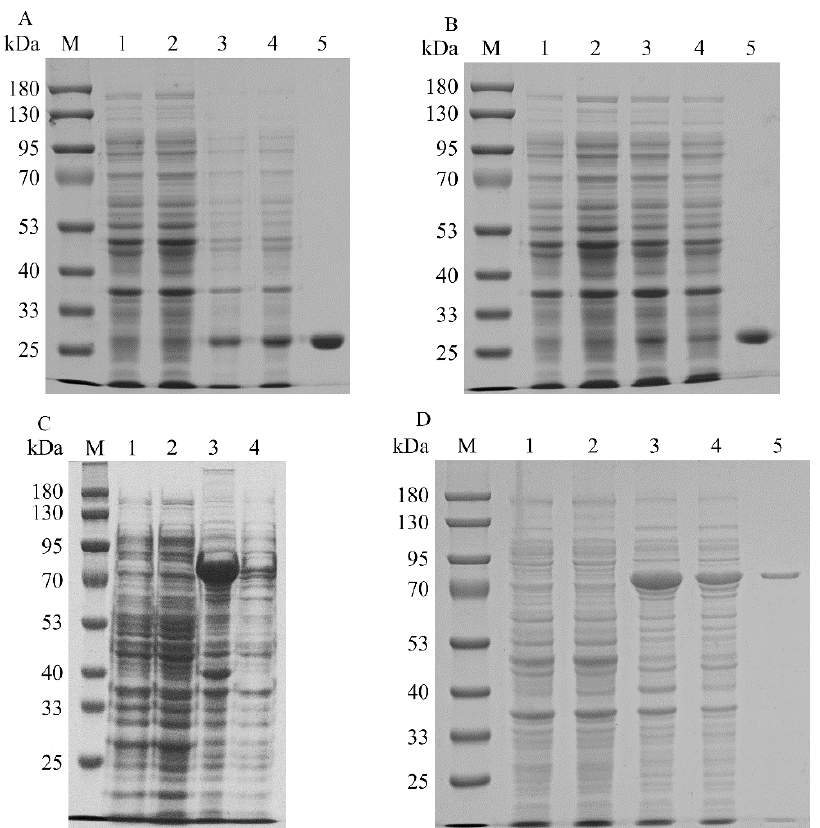
Figure 2. SDS–PAGE analysis of recombinant promiscuous kinases in E. coli : ( A ) SDS–PAGE Figure 2. SDS – PAGE analysis of recombinant promiscuous kinases in E. coli : ( A ) SDS – PAGE analy-